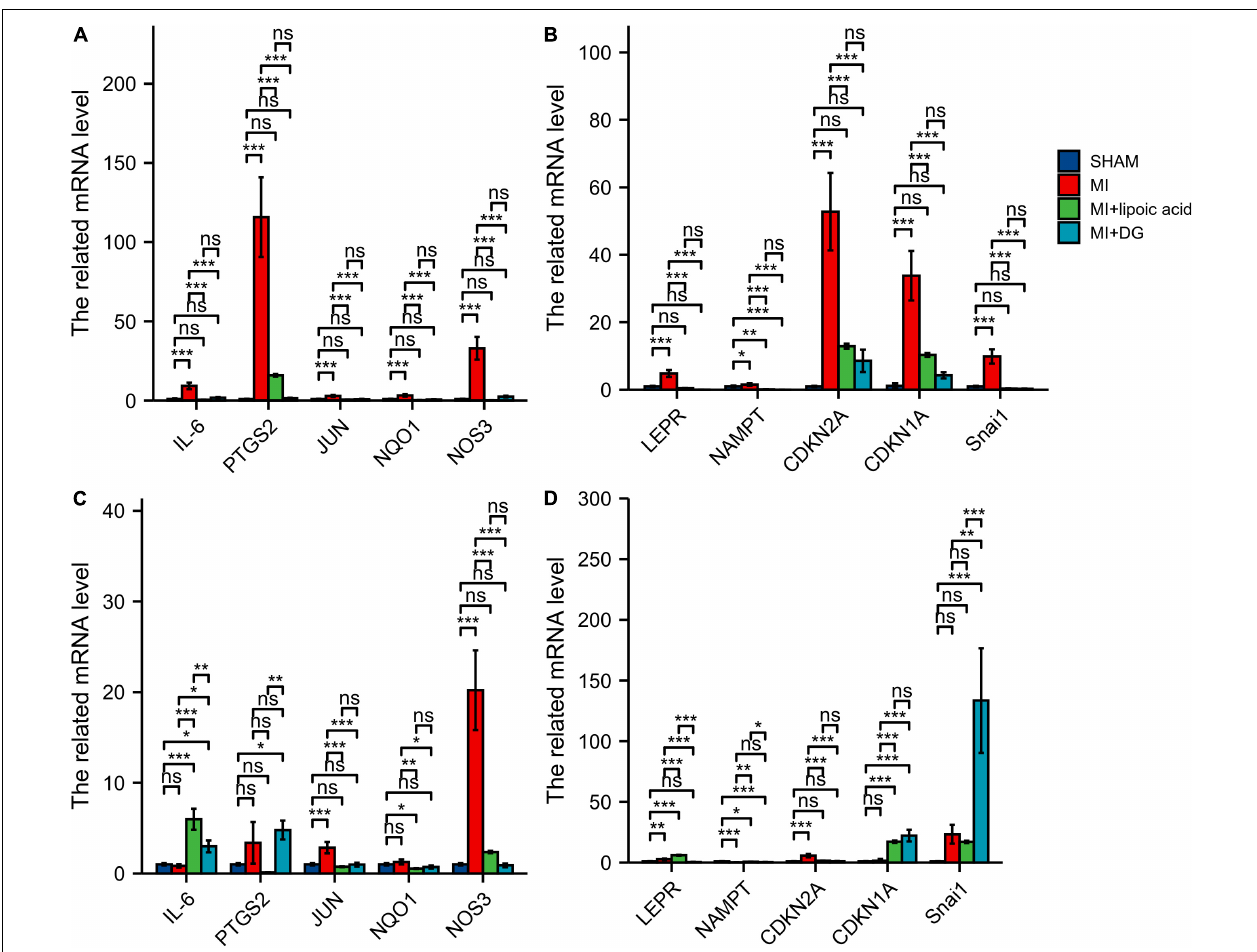
FIGURE 9 | qRT-PCR results show the expression levels of ferroptosis-related and autophagy-related hub genes. (A) The related mRNA levels of IL-6, PTGS2, JUN, NQO1, and NOS3 at 3 days after MI. (B) The related mRNA levels of LEPR, NAMPT, CDKN2A, CDKN1A, and Snai1 at 3 days after MI. (C) The related mRNA levels of IL-6, PTGS2, JUN, NQO1, and NOS3 at 1 week after MI. (D) The related mRNA levels of LEPR, NAMPT, CDKN2A, CDKN1A, and Snai1 at 1 week after MI. * p < 0.05; ** p < 0.01; *** p < 0.001; ns, not significant.